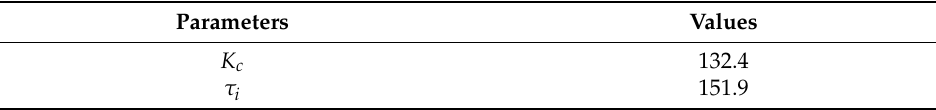
Table 6. Tuned PI controller parameters.